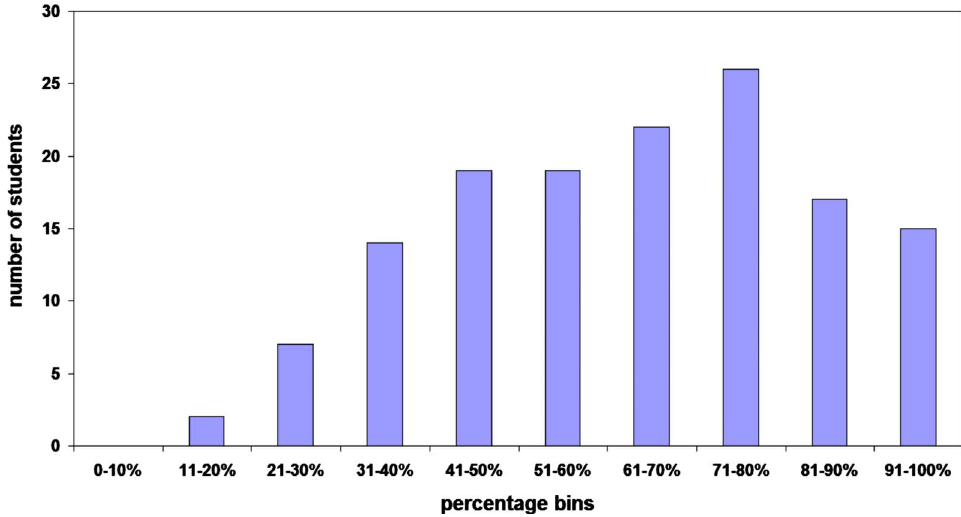
FIG. 2. (cid:1) Color (cid:2) Distribution of test scores for